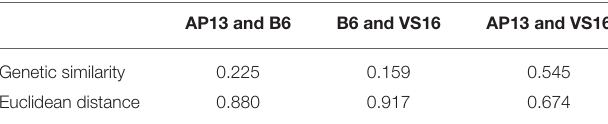
TABLE 2 | Genetic similarity and Euclidean distances calculated between